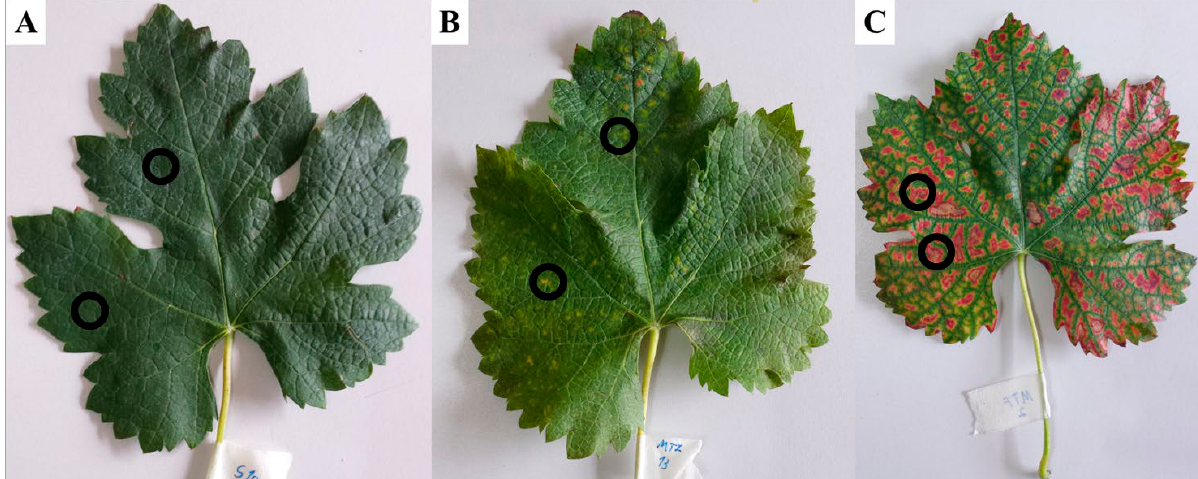
Figure 1. Grapevine leaves from a ‘Merlot’ vineyard in Serra Gaúcha region, Brazil. (A) asymptomatic; (B) with initial symptoms and (C) with final symptoms of Grapevine Leaf Stripe Disease (GLSD. Open black circles indicate leaf clip sen- sor positions during spectroradiometric